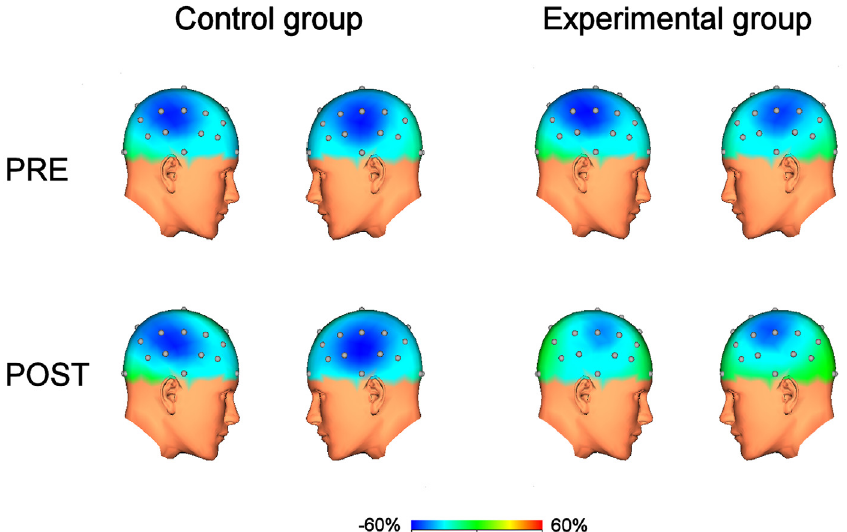
Fig 3. Pre and post grand-average TRD representations during motor performance in the two groups. In the control group, no significant differences were observed between the “ pre ” and “ post ” conditions. In the experimental group, motor performance-induced TRD was present bilaterally over sensorimotor areas and was significantly reduced in terms of amplitude and area after